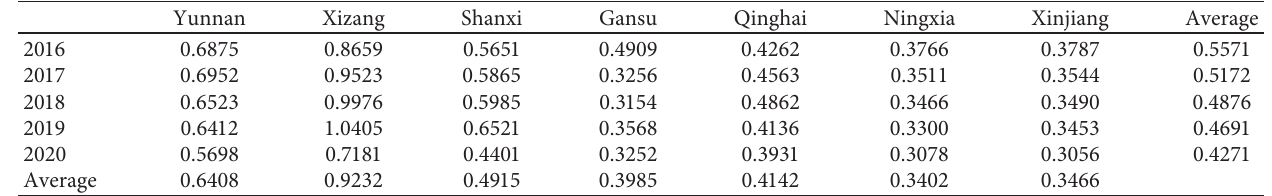
Table 4: Performance evaluation values of the system for urban workers in the western